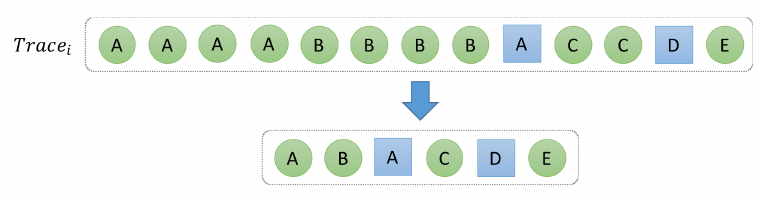
Figure 4. Elimination of duplicate